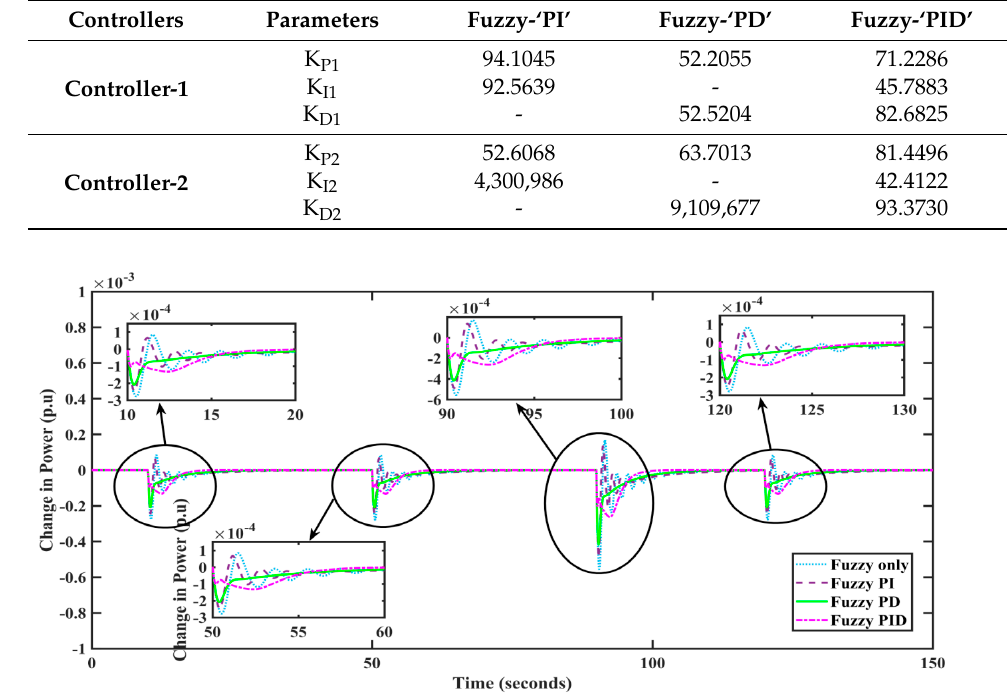
Figure 22. Dynamic response comparison of different control configurations of IHPS change in power for the random load disturbance. Table 5. Optimal parameters for both control 1 and 2 using ABC algorithm for Case 1 (1% step change in load).